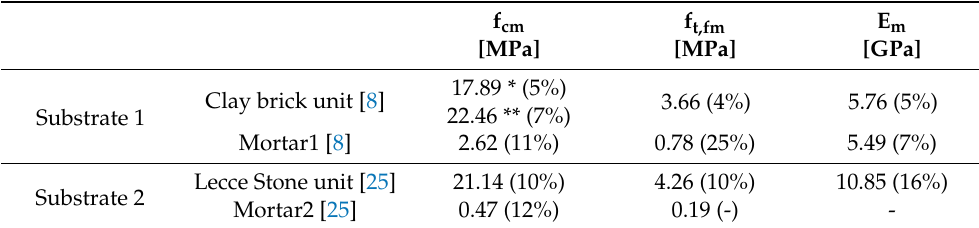
Table 1. Mechanical properties of substrate elements.